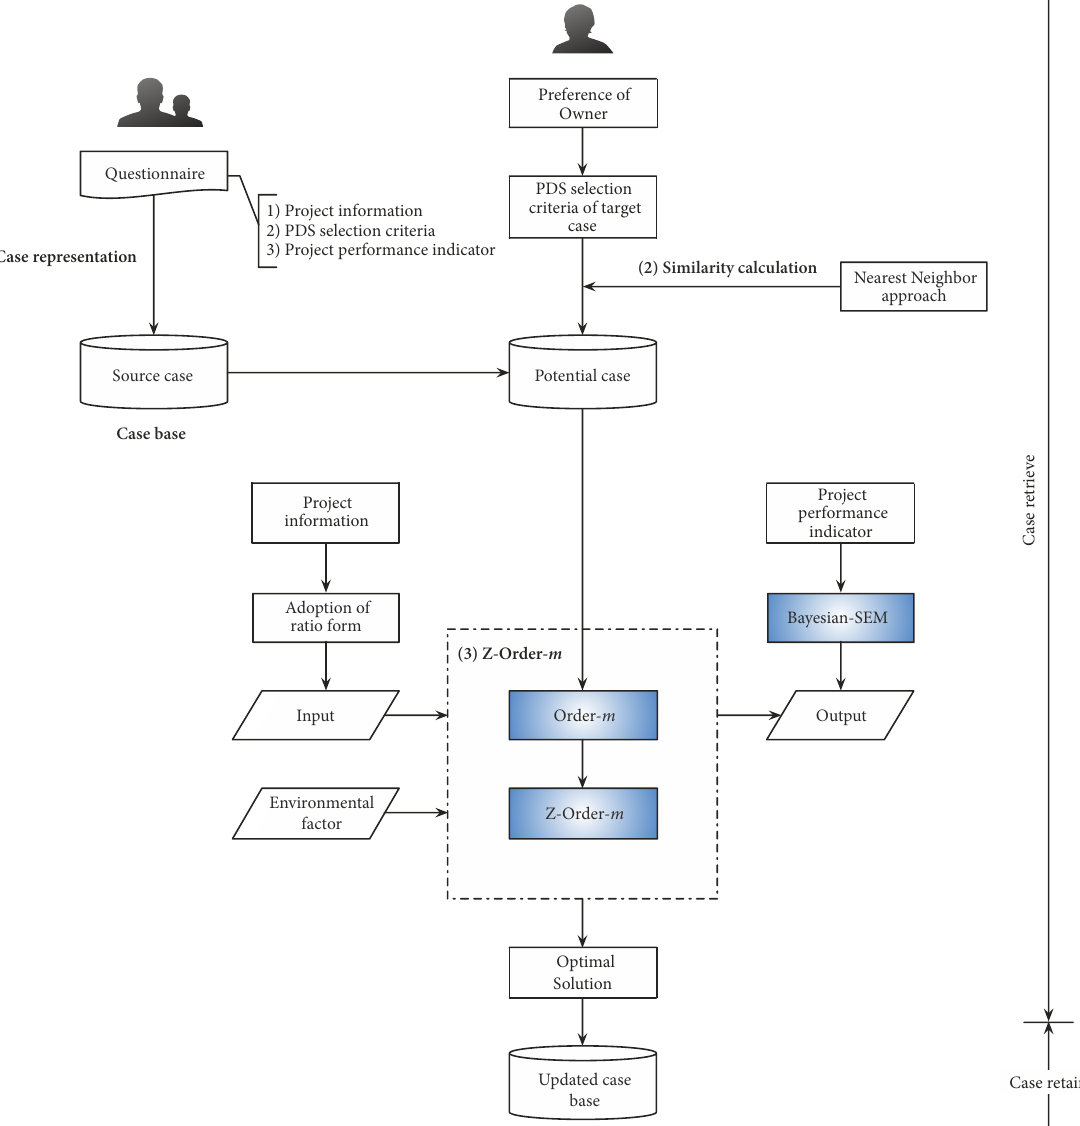
Figure 1. Structure of the proposed research based on the robust non-parametrical production frontier